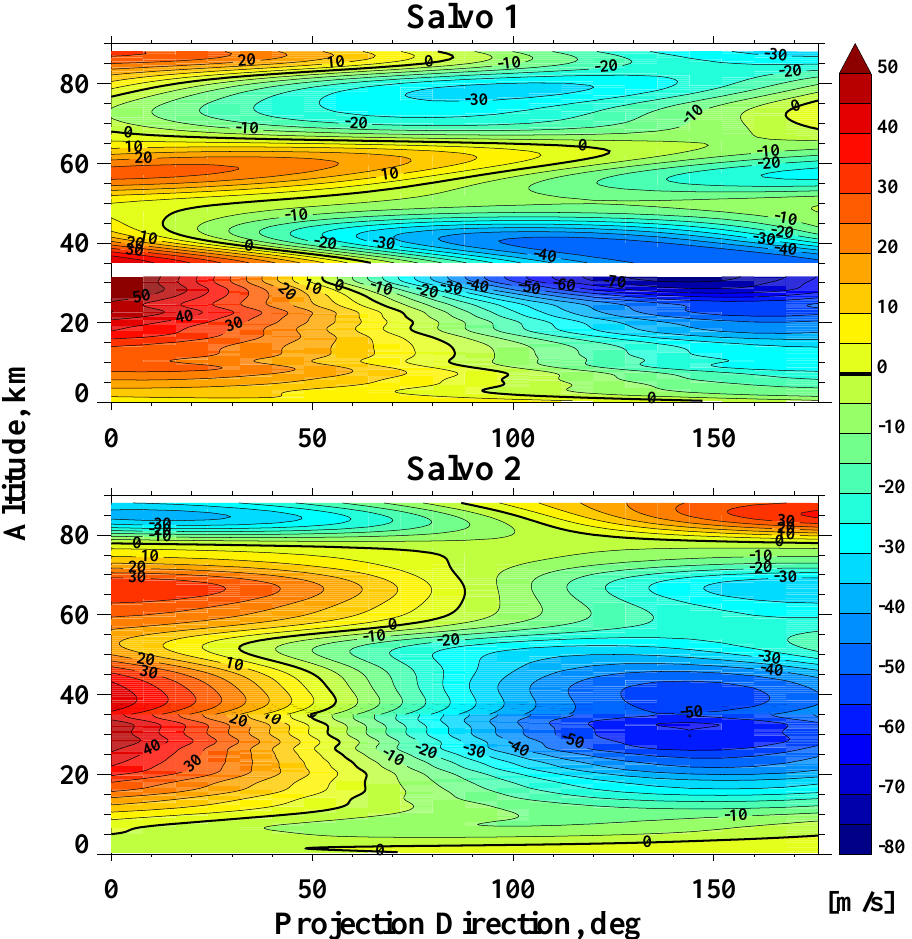
Fig. 10. Projection of salvo mean wind vectors on different directions ranging from 0 to 178 ◦ . The direction is measured counter clockwise from the East. The contour interval is 5ms − 1 . The zero wind line is marked by thick solid line. The blank region for Salvo 1 is due to a data gap. See text for